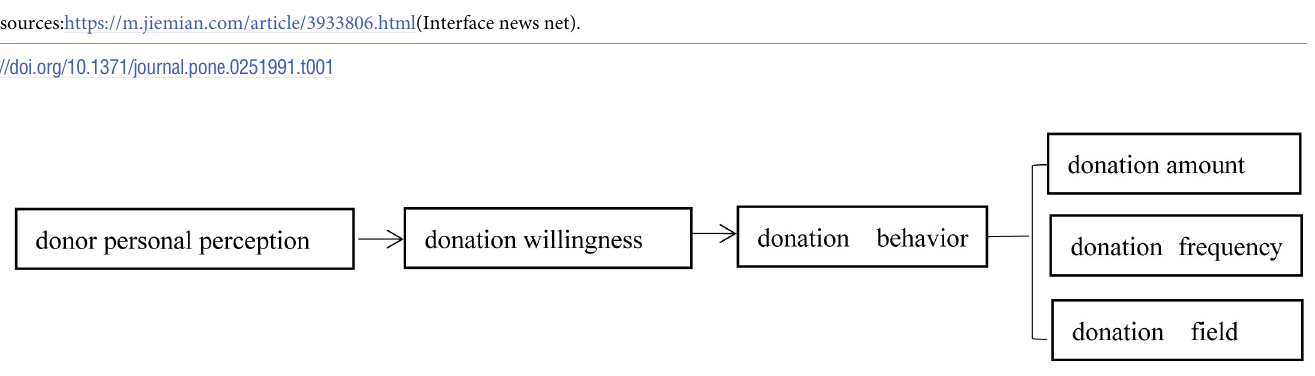
Fig 1. The impact of the donor’s personal perception on the donation.